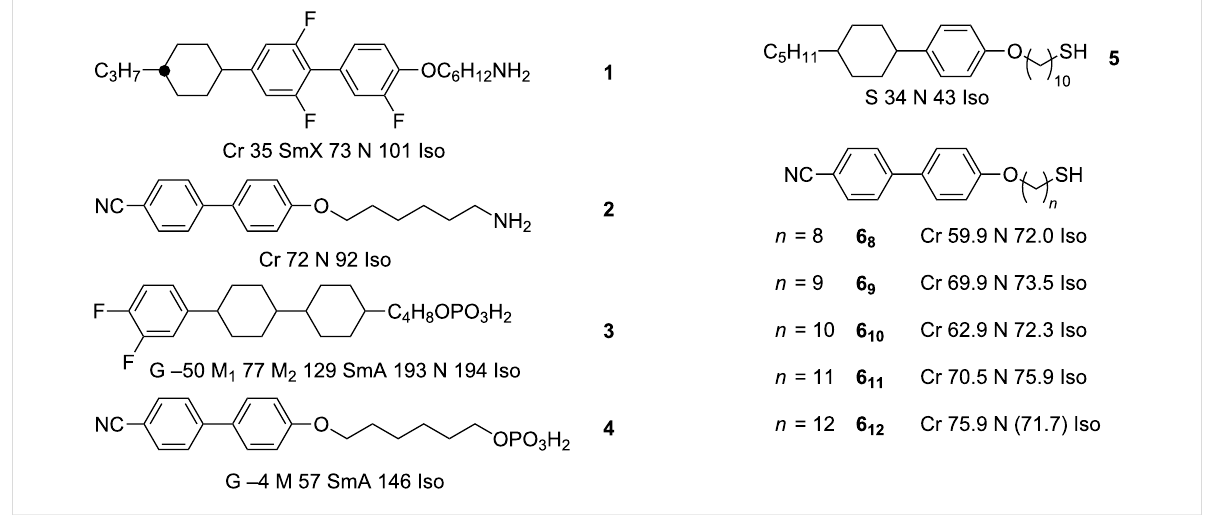
In an extension of this work, mesophase behaviour was reported for systems involving α -Fe 2 O 3 NPs coated with mesogenic ligands containing a phosphonic acid anchoring group [59]. The NPs were prepared by using a sol–gel method, and grafting of the ligands was undertaken with 1:1 and 1:2 ligand/NP mass ratios. Mesogenic behaviour was observed for spindle-shaped α -Fe 2 O 3 @3 1:2 hybrids, with those prepared with NPs ~300 nm long and ~50 nm wide at 90 °C displaying a marbled texture under polarised optical microscopy (POM). SAXS experiments indicated the existence of periodic particle interac- tions at intervals of 49.7 and 46.5 nm respectively, which molecules on the surface. As was observed for TiO 2 @1 , these results indicated that the hybrids of α -Fe 2 O 3 @3 exhibited a quasi-nematic one dimensional order in the direction of the long axis of the spindlelike NPs, which was lost upon the use of